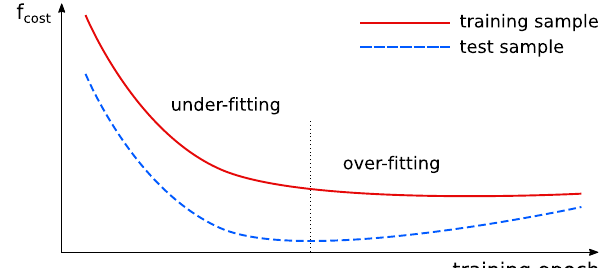
Fig. 5 Demonstration of early stopping regularization technique: the cost function for training (red solid curve) and test (blue dashed curve) samples as a function of training